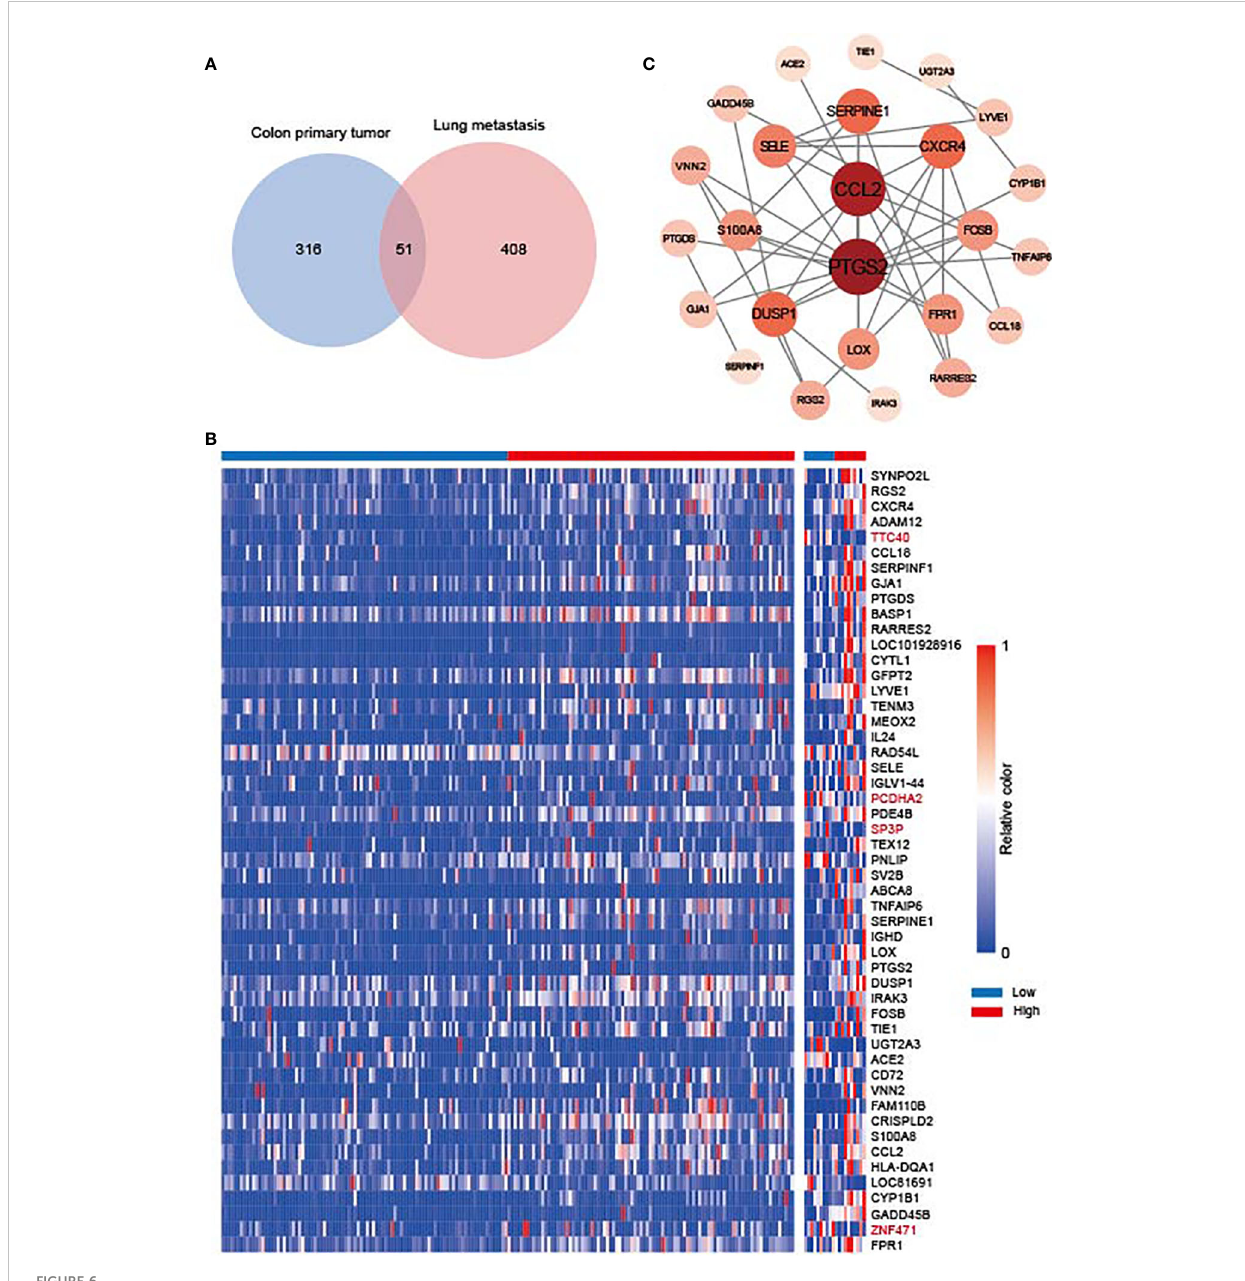
FIGURE 6 The gene difference in colon primary tumor and lung metastasis. (A) Venn diagram for differentially expressed genes (DEGs) between colon primary tumor and lung metastasis in the GSE68468 dataset. (B) Heat map of 51 shared DEGs. (C) Interplay network of DEGs and two hub genes through STRING and